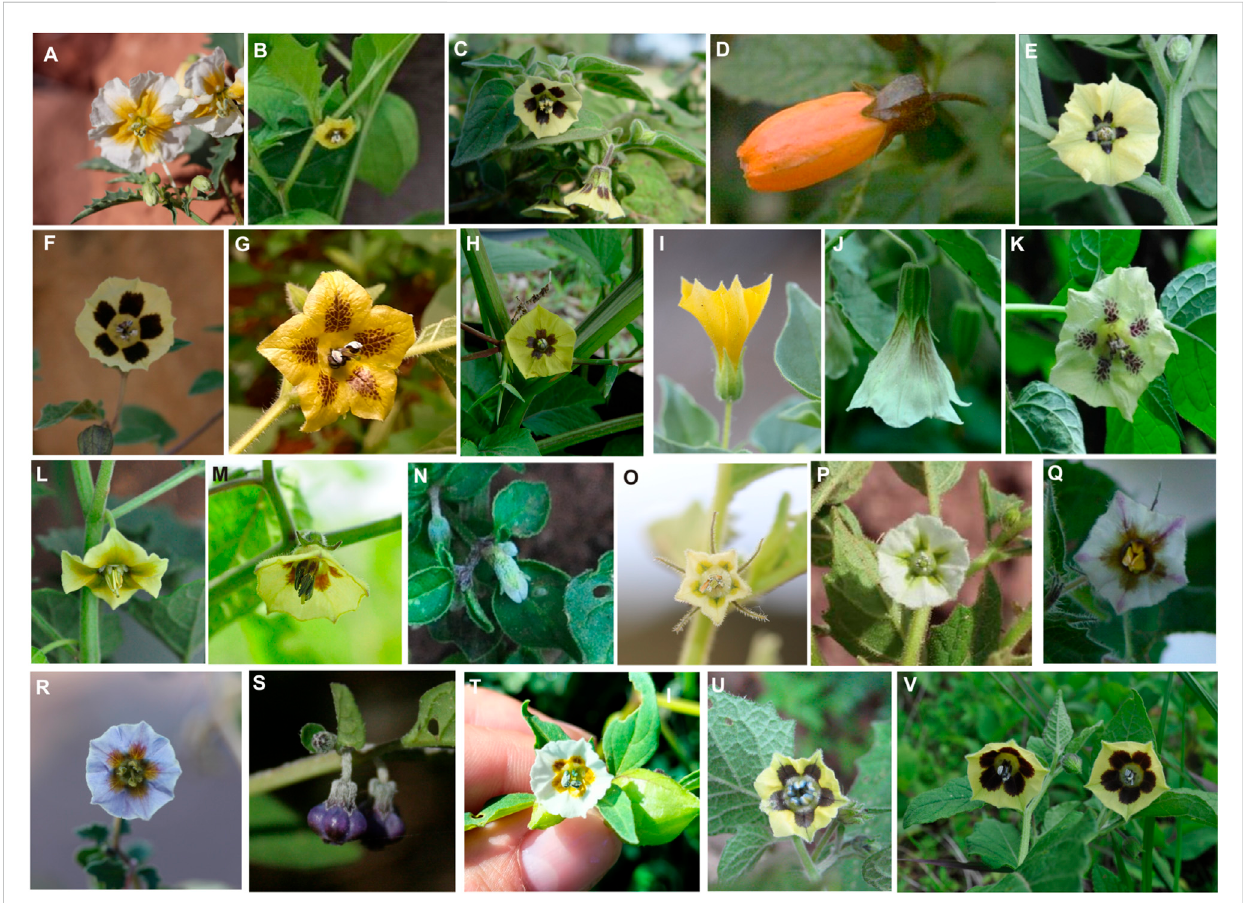
FIGURE 1 Corolladiversityof Physalis spp. (A) P.acutifolia , (B) P.angulata , (C) P.angustiphysa , (D) P.campanula , (E) P.cinerascens , (F) P.chenopodiifolia , (G) P. coztomatl , (H) P. cordata , (I) P. crassifolia var. infundibularis , (J) P. glutinosa , (K) P. greenmanii , (L) P. hederifolia , (M) P. latiphysa , (N) P. microcarpa , (O) P. nicandroides , (P) P. patula , (Q) P. pruinosa , (R) P. purpurea , (S) P. solanacea , (T) P. sulphurea , (U) P. tamayoi , (V) P.